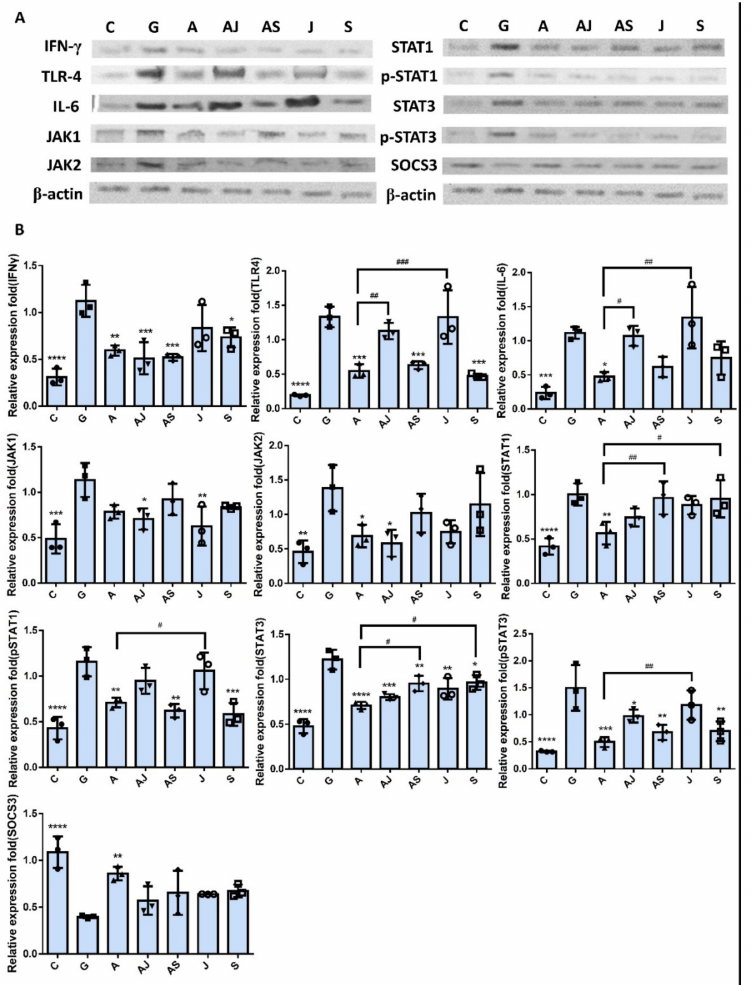
Figure 8. JAK and STAT inhibitors affected the RNase 7-downregulated protein expressions associated with the JAK/STAT signaling pathway and inflammation in UPEC-infected bladder cells in a